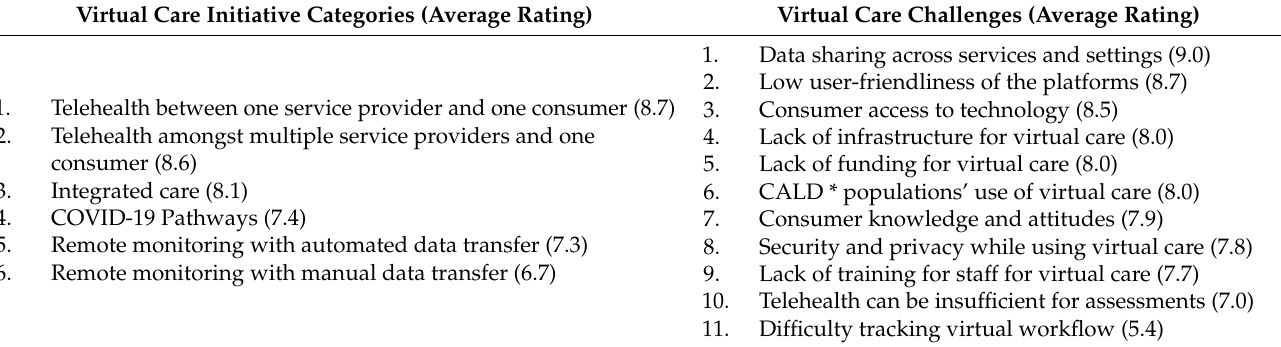
Table 2. Perceived priority of virtual care initiative categories and challenges for scaling up or addressing, listed in order of highest to lowest priority.